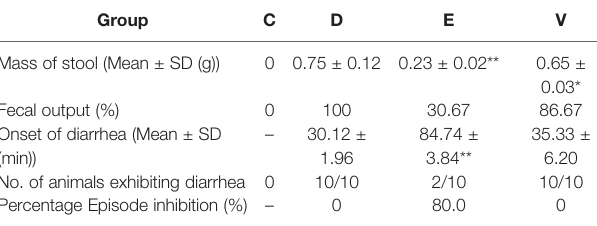
TABLE 2 | Effect of EA on castor oil-induced diarrhea in